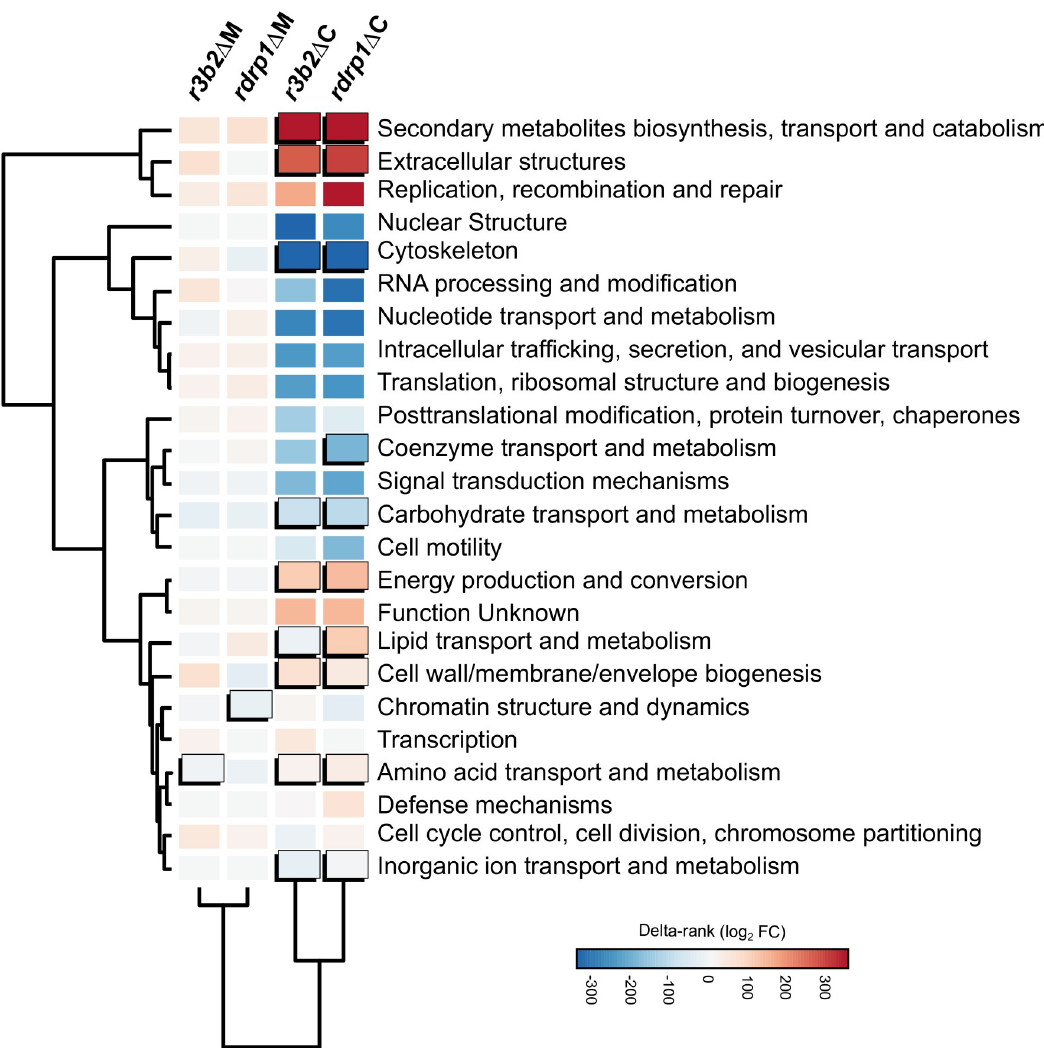
Fig 2. NCRIP regulates key functional categories involved in saprophytic growth. Enrichment analysis of DEGs in each Eukaryotic Orthologous Groups (KOG) class. Significant enrichments (Fisher’s exact test, P � 0.05) in a given mutant strain and condition compared to the wild-type strain are shown as uplifted rectangles. A measure of up- (red) or downregulation (blue) of each KOG class is represented as a colored scale of delta-rank values (the difference between the mean rank differential expression value of all genes in each KOG class and the mean rank differential expression value of all other genes). KOG classes and experimental conditions (mutant strains and presence/absence of macrophages) are clustered according to the similarity of their delta rank